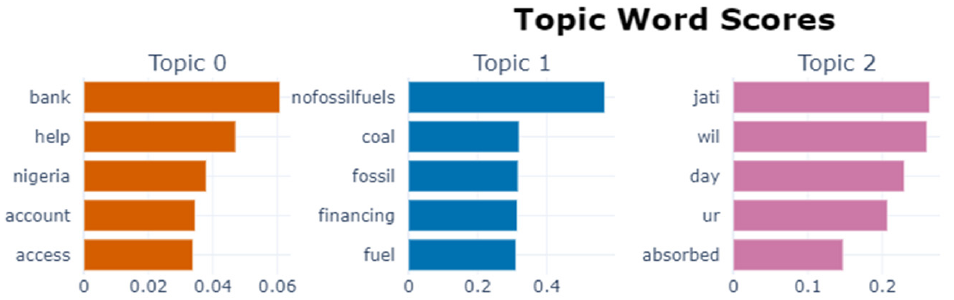
Figure 2. BERTopic Figure 2. BERTopic terms.